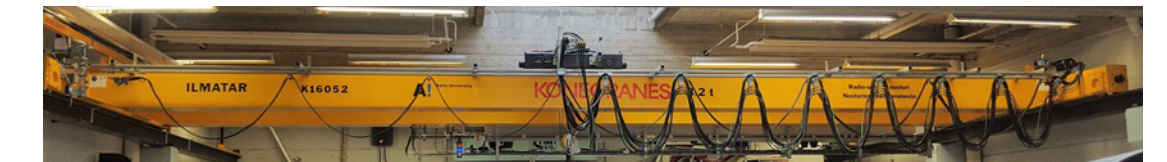
Figure 7. An overhead crane located at the Aalto Industrial Internet Campus